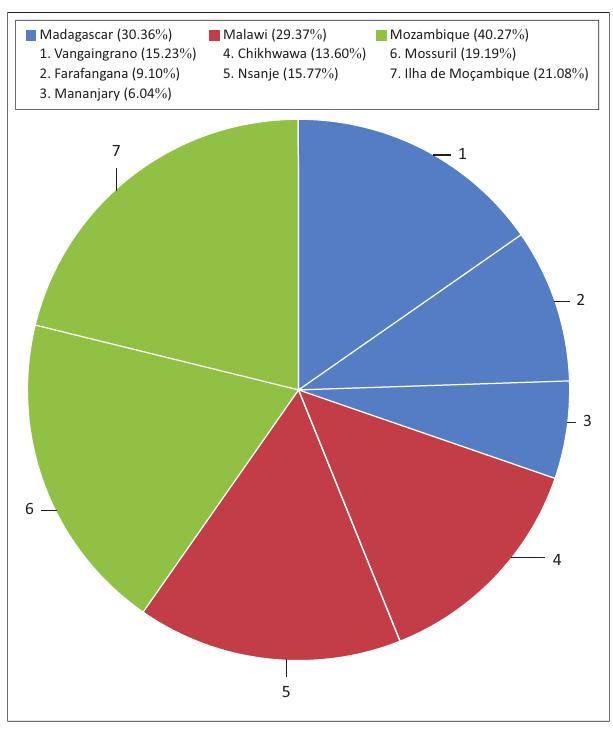
FIGURE 1: Survey